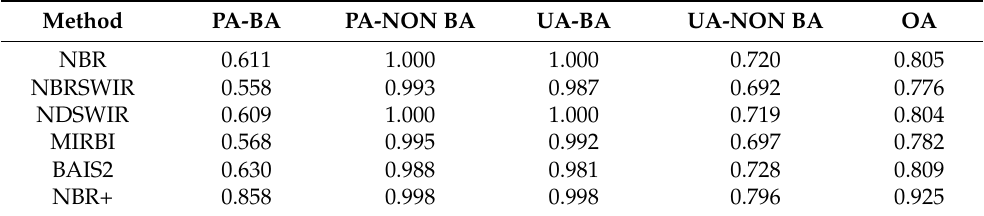
Table 3. Results of single-date thematic accuracy assessment on test sites excluding water bodies and clouds (Group B).